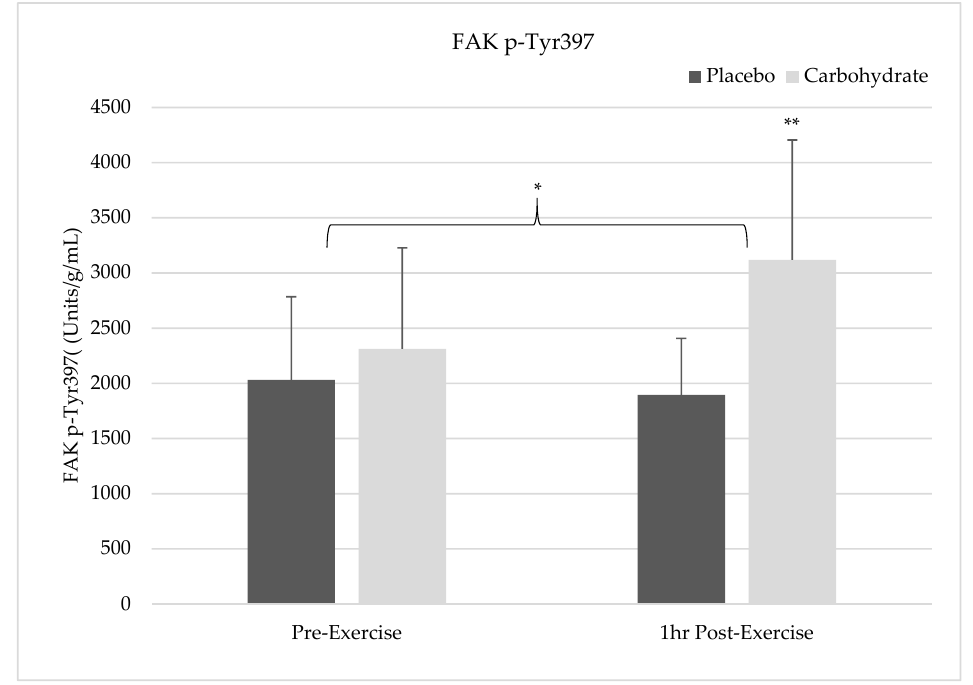
Figure 1. Changes in focal adhesion kinase (FAK) phosphorylation at Tyr 397 for each time point and